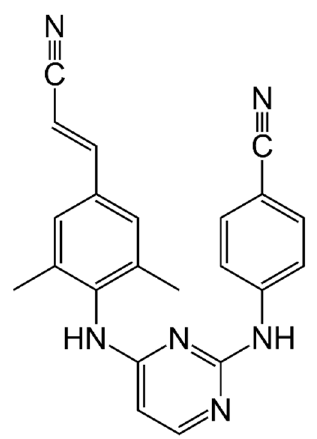
Figure 3. Rilpivirine. Figure 3.